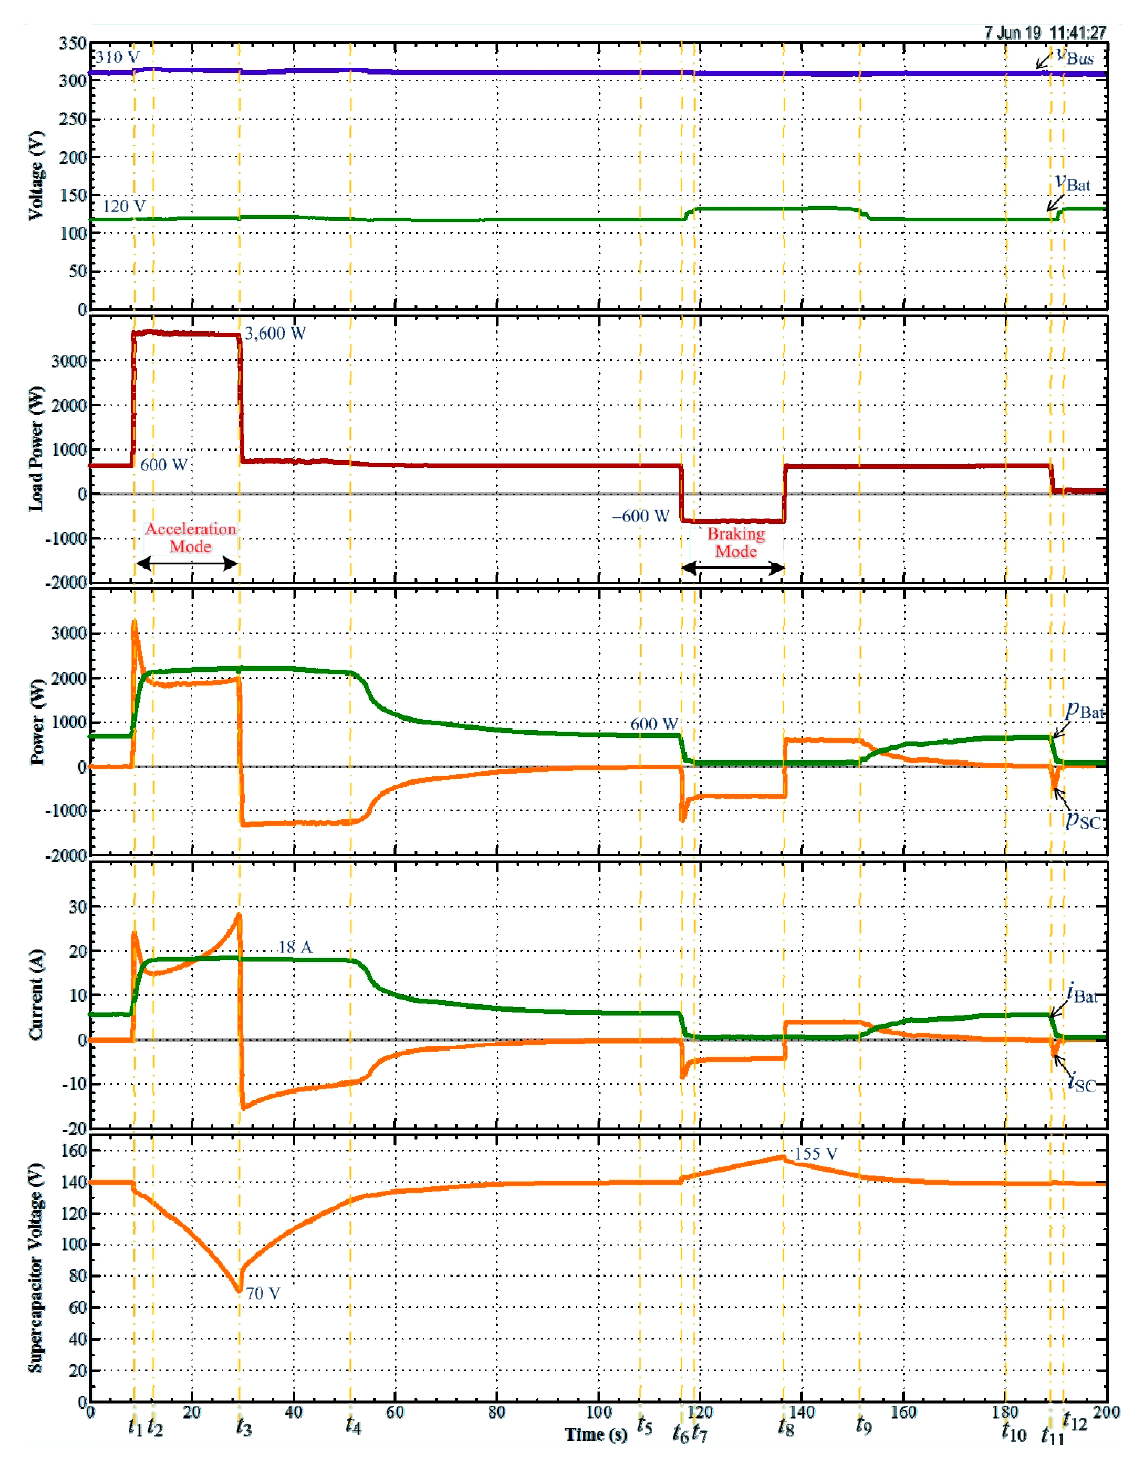
Figure 12. Hybrid source response during load drive cycles.